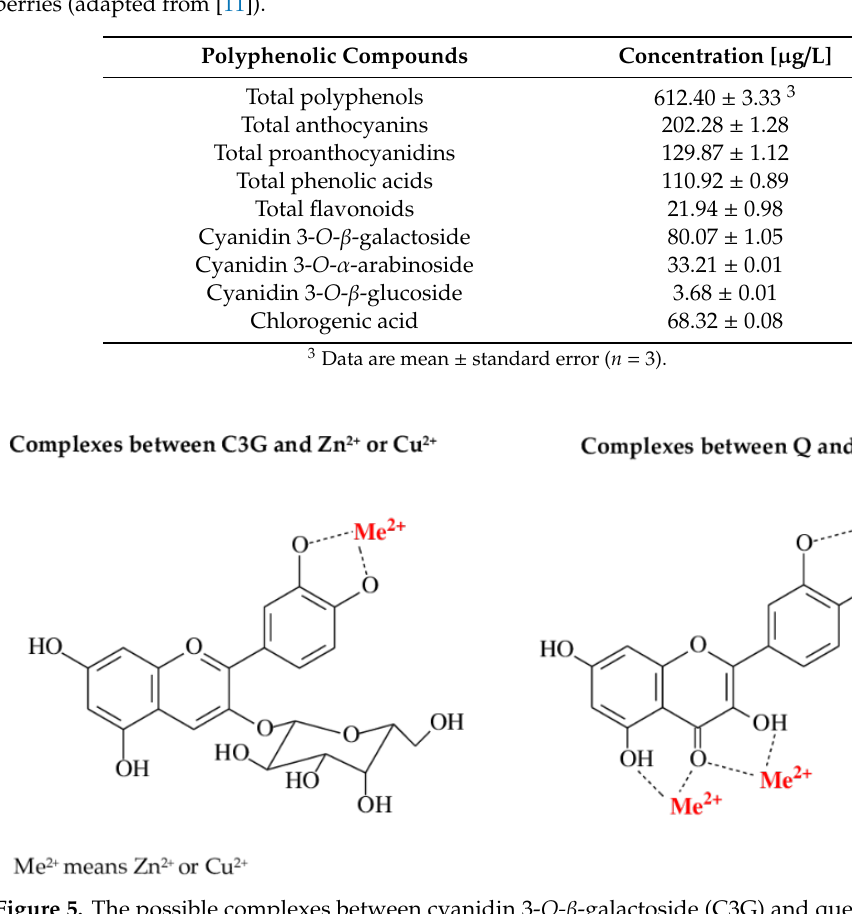
Figure 5. The possible complexes between cyanidin 3- O- β -galactoside (C3G) and quercetin (Q) and divalent ions of zinc (Zn 2+ ) and copper (Cu 2+ ).